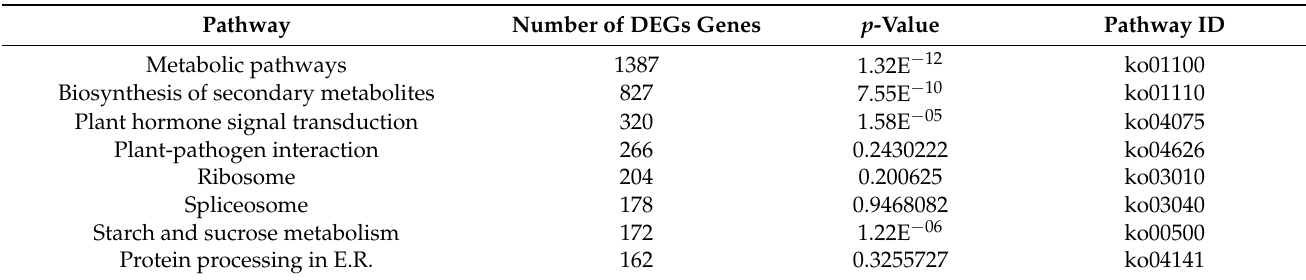
Figure 5. GO function analysis of the differentially expressed genes. GO function analysis results for the differentially expressed genes in cambial tissues due to winter and spring seasons into biological processes, cellular components, and molecular functions. Table 4. Top 25 DEG enriched KEGG pathways.